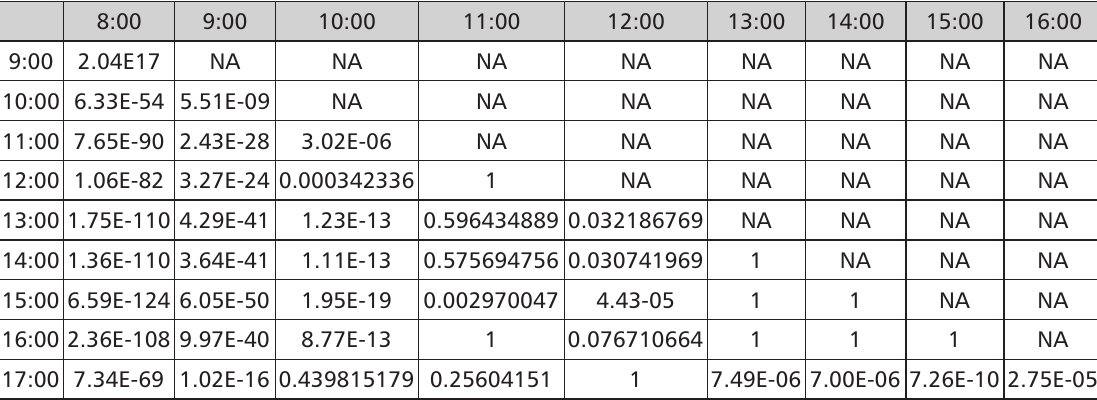
TABLE 3 p-values from t-test species, air temperature Malay almond 1 Malay almond 2 Rain tree Malay almond 2 Redwood tree Honey mesquite Rain tree Honey berry TABLE 4 p-values from t-test species, surface temperature Malay almond 1 almond 2 Malay almond 2 Redwood tree Honey mesquite Rain tree Honey berry Surface TABLE 5 p-values from t-test especies, hour air